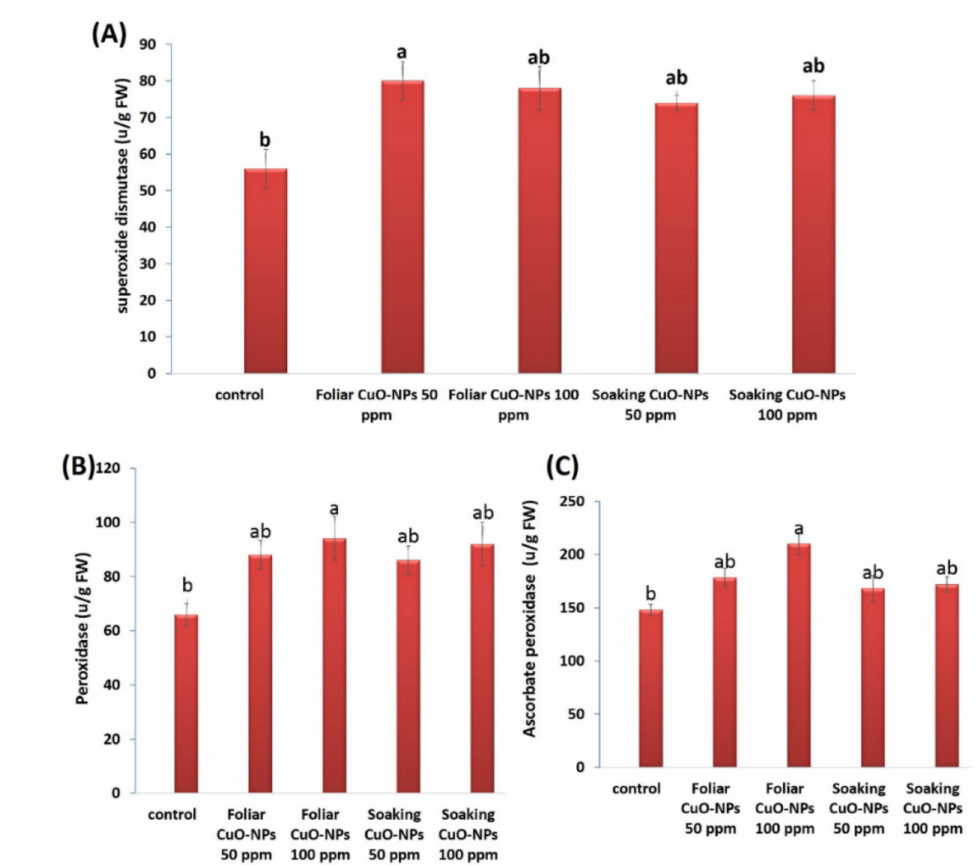
Figure 7. Antioxidant enzymatic activities of a wheat plant treated with CuO-NPs at two concentra- tions (50 and 100 ppm) by foliar spray and soaking method. ( A ) Superoxide dismutase, ( B ) peroxidase, and ( C ) ascorbate peroxidase activities (unit/g FW). Data are statistically different at p ≤ 0.05 by Tukey’s test, ( n = 3); different letters on bars indicate that mean values are significantly different at a significant level of ( p ≤ 0.05), error bars are means ± standard error